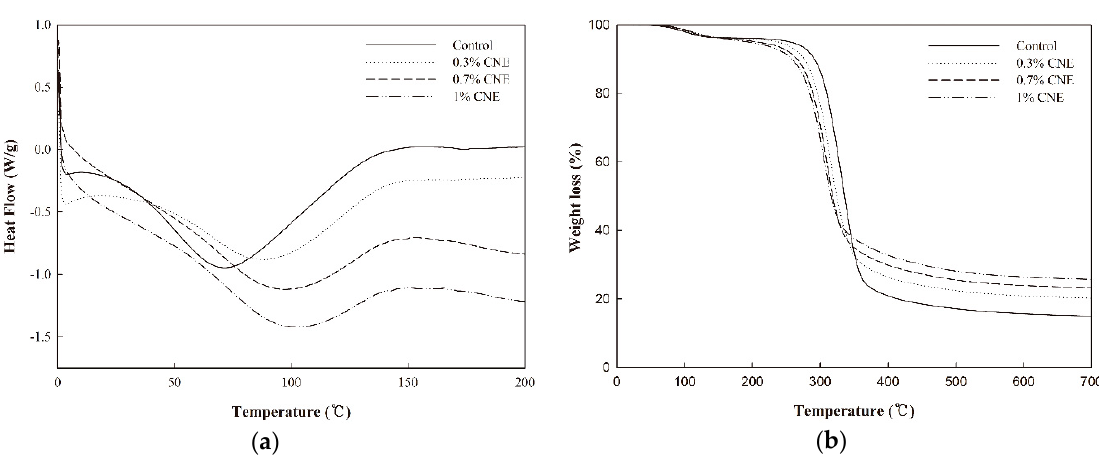
Figure 5. Thermal properties of adzuki bean starch films containing cocoa nibs extract. ( a ) Differential scanning calorimetry (DSC); ( b ) Thermogravimetric analysis (TGA).